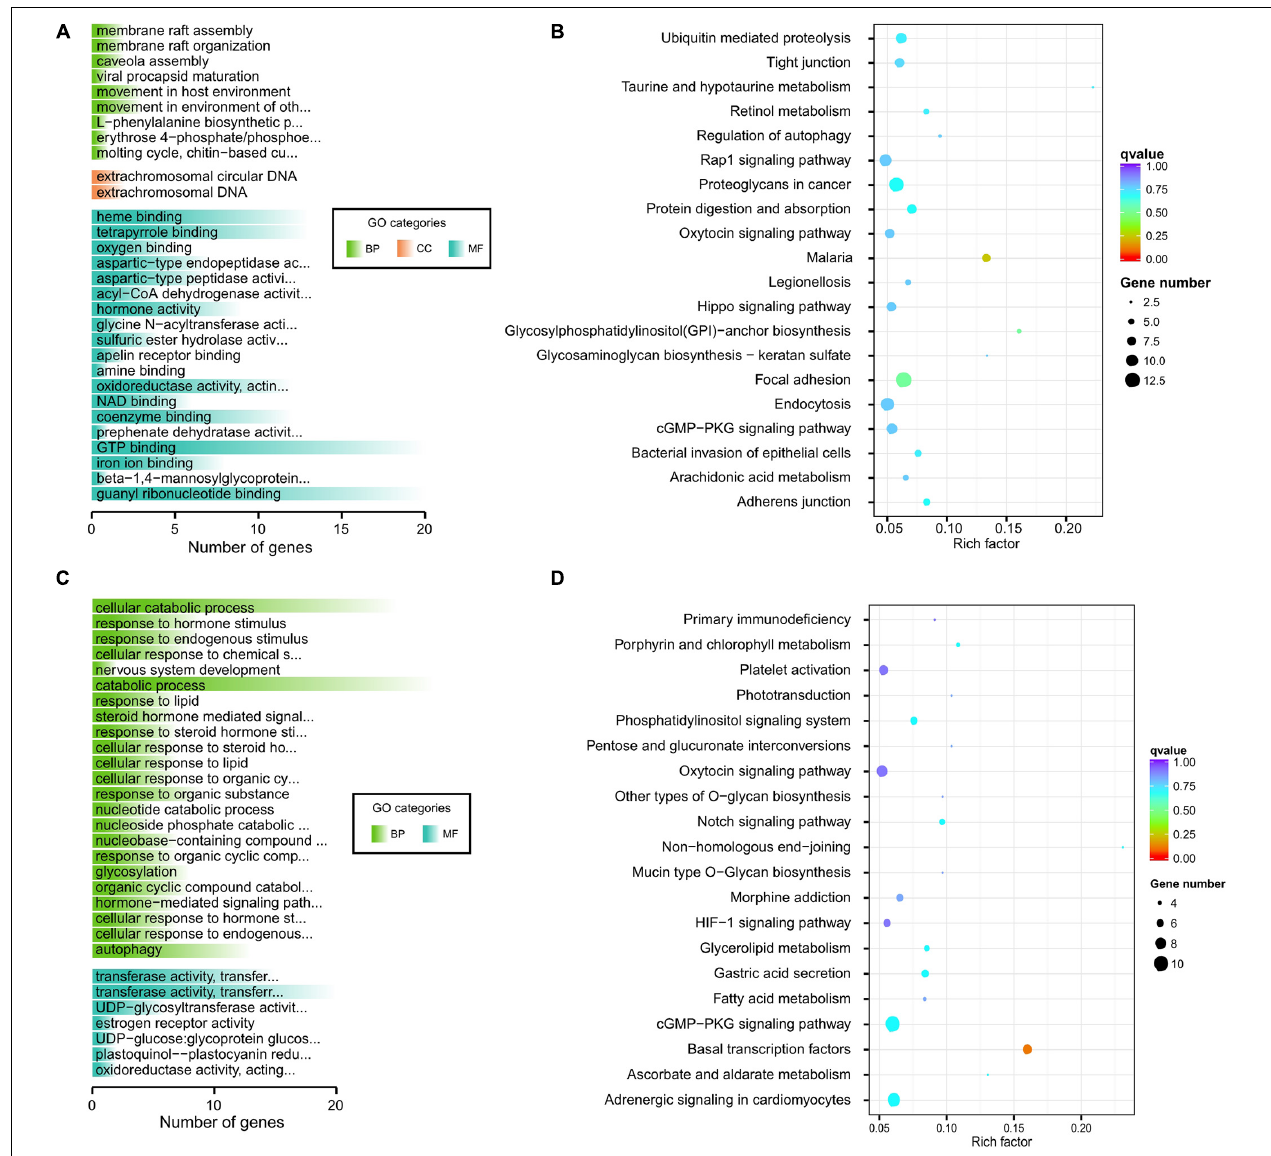
FIGURE 4 | GO and KEGG analysis of horn traits. (A) Go categories of horned group. (B) KEGG of horned group. (C) Go categories of polled group. (D) KEGG of polled